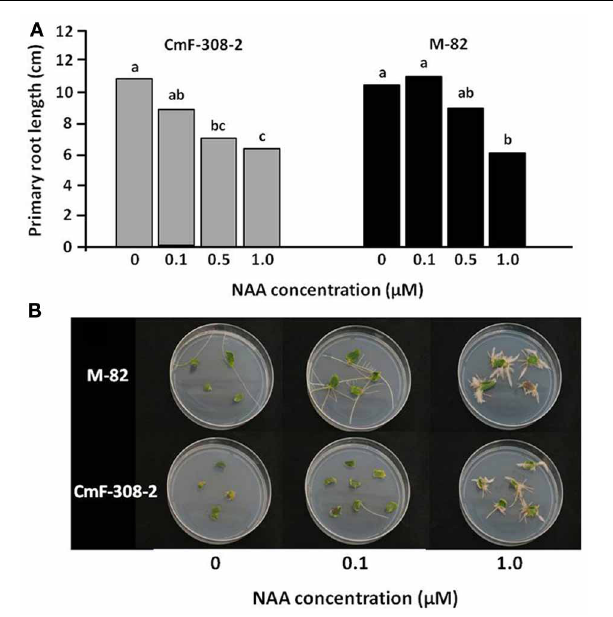
FIGURE 7 | Auxin response of CmF-308- transgenic tomato plants. (A) Primary root length of CmF-308-2 and control M-82 tomato seedlings after incubation in various concentrations of NAA. Seedlings were germinated on filter paper soaked in the auxin solutions in the dark. Lengths of primary roots were measured 10 days after germination. Data represent means of eight replications ± SE. Different letters indicate significant differences between auxin concentration treatments in each plant line Axillary at p < 0 . 05 by Tukey’s HSD-test. (B) Auxin dose-response assay of cotyledon explants showing reduced auxin sensitivity in CmF308-2 cotyledons as compared to controls. Root regeneration is promoted by 0.1 µ M NAA in the control variety and by 10 times higher concentration (1.0 µ M NAA) in the transgenic line CmF-308-2. Pictures of representative plates were taken 12 days after placing the cut cotyledons on the various auxin